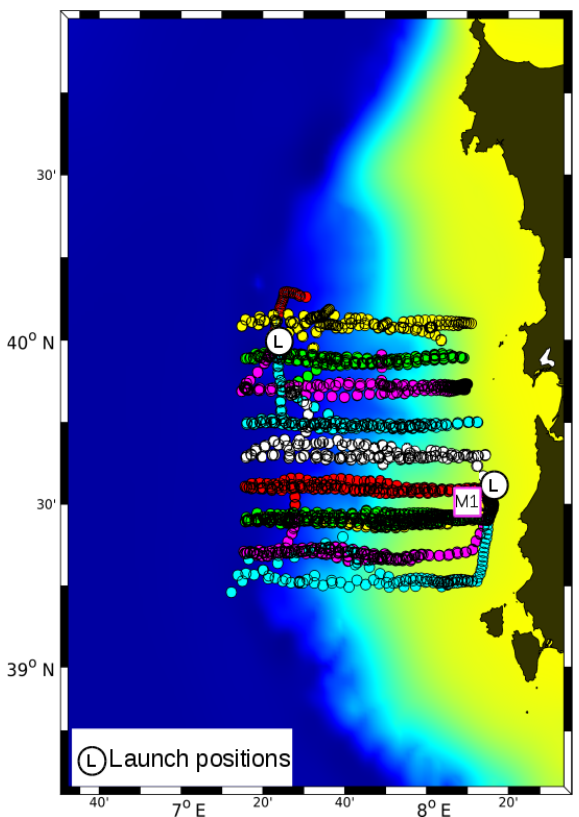
Figure 4. The actual glider tracks during 8–23 June. The small cir- cles along the tracks show the surfacing positions. Each glider is marked by a different colour. The colour code for the bathymetry is the same as in Fig.